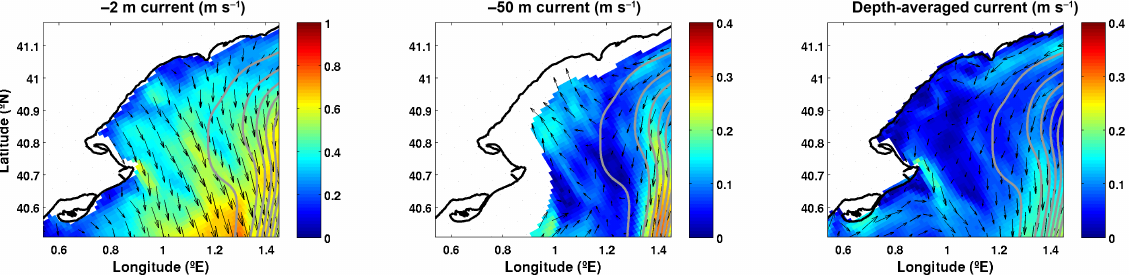
Figure 9. Modelled circulation at − 2m (left panel), − 50m (centre panel) and depth-averaged circulation (right panel) during the peak of the wind jet event (i.e. 21 May 2012, 06:00UTC). The quiver is shown for each of the four computational points. Grey lines are shown for each of the 100 isobaths. Note differences in the velocity ranges among the sub-plots.